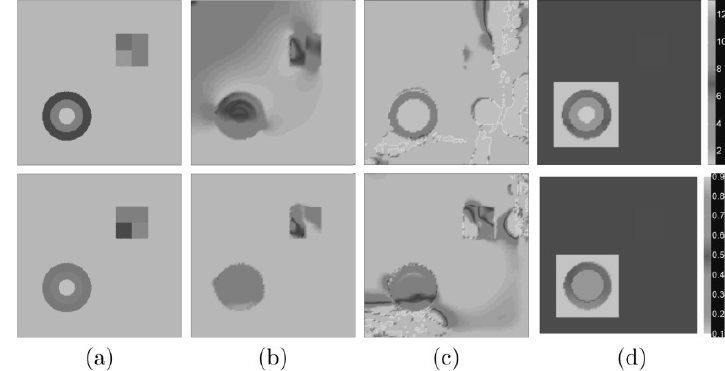
Figure 7. Simulation results for local reconstruction. First row: images of µ . Second row: images of η µ . (a) true image; (b) initial guess; (c) adjoint-based optimization method; (d) local